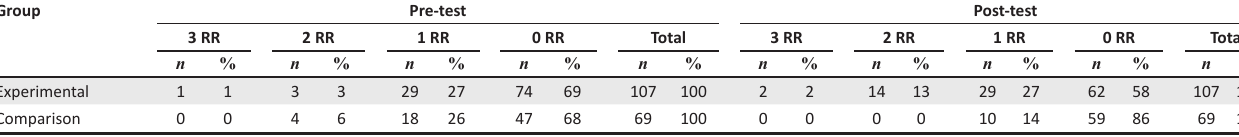
TABLE 3: Number of learners producing realistic reactions. Group